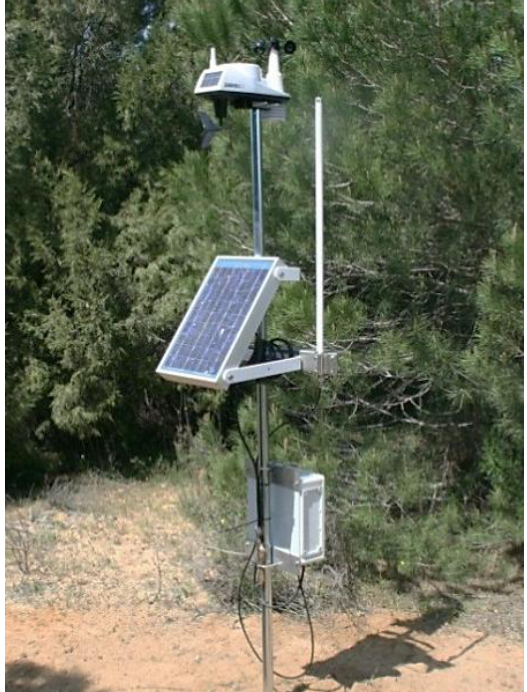
Figure 7. Node of the ICARO 1